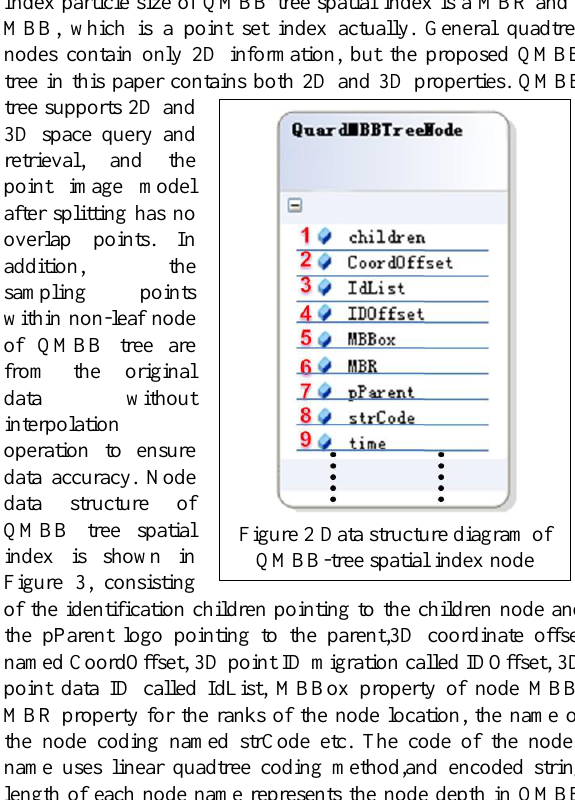
Figure 2 Data structure diagram of QMBB-tree spatial index node